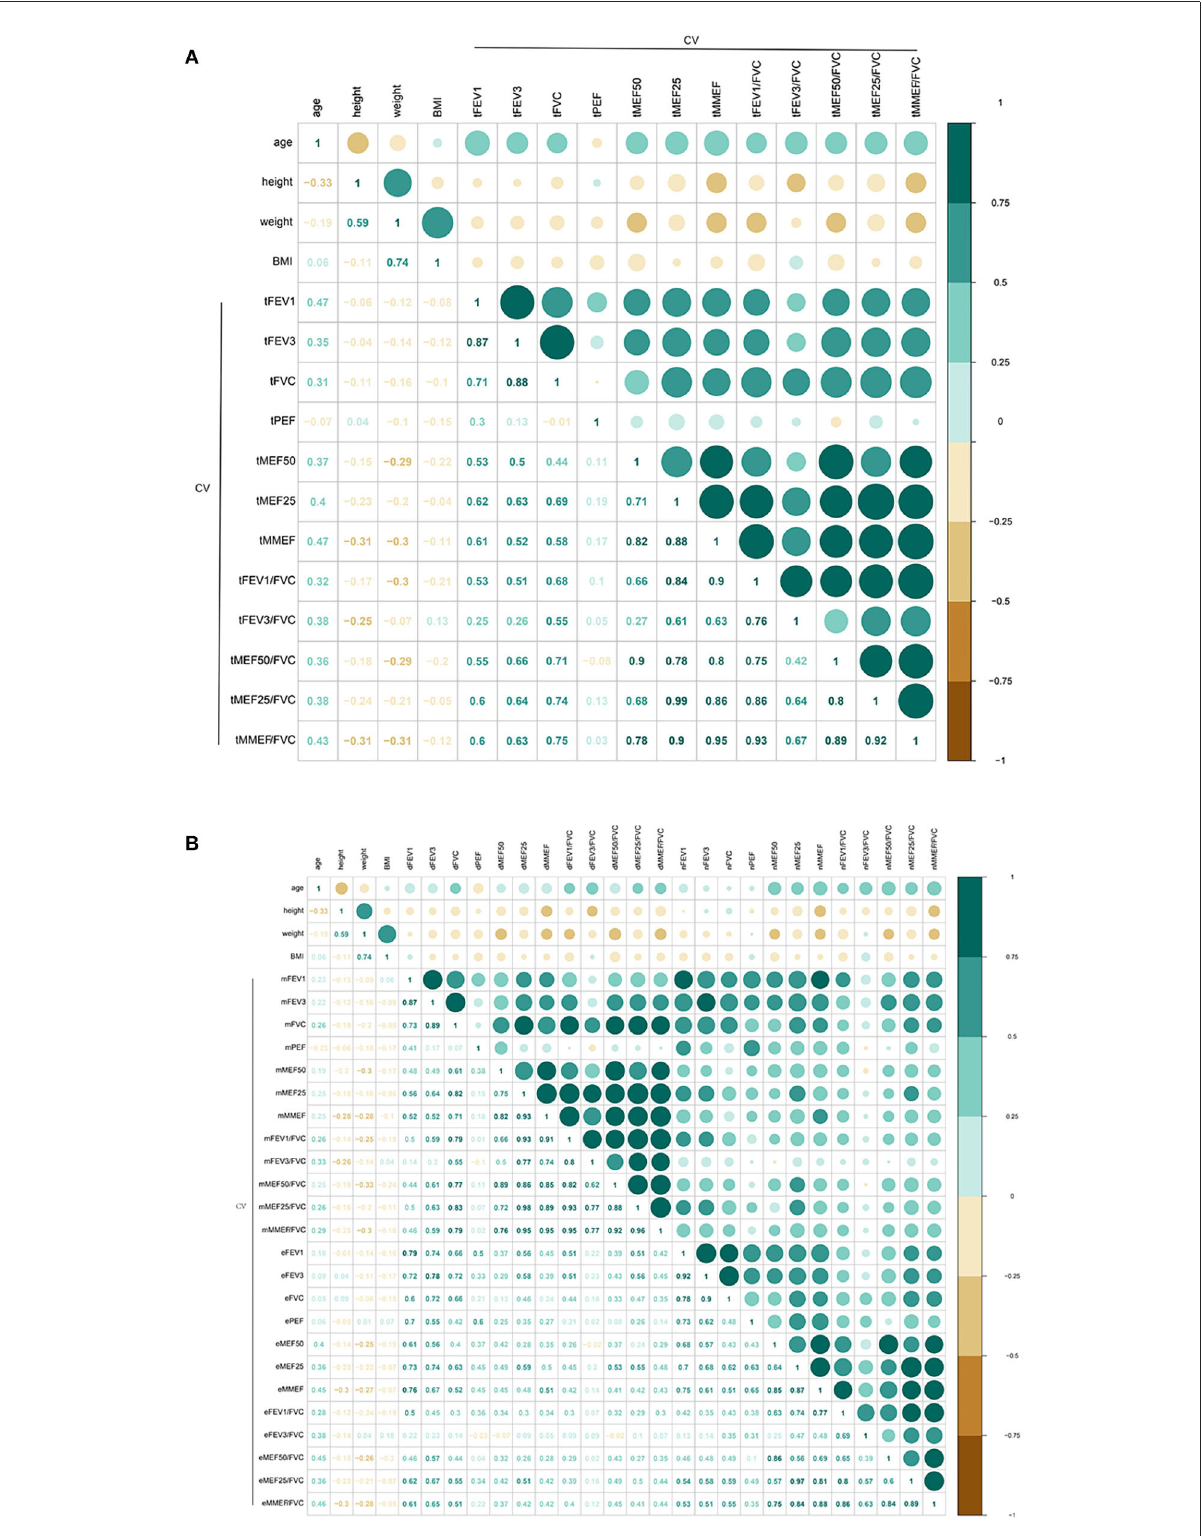
FIGURE4 Correlation of CV of pulmonary function variable values with age, height, weight, and BMI (total, morning, and evening) ( N = 31, except N = 30 for PEF). A strong relationship between age and both large- [ (A) , r = 0.47, P = 0.0082 for tFEV 1 ] and small-airway (tMEF25, tMMEF,